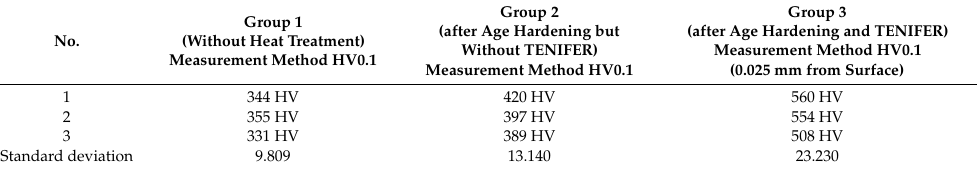
Table 1. Microhardness measurement